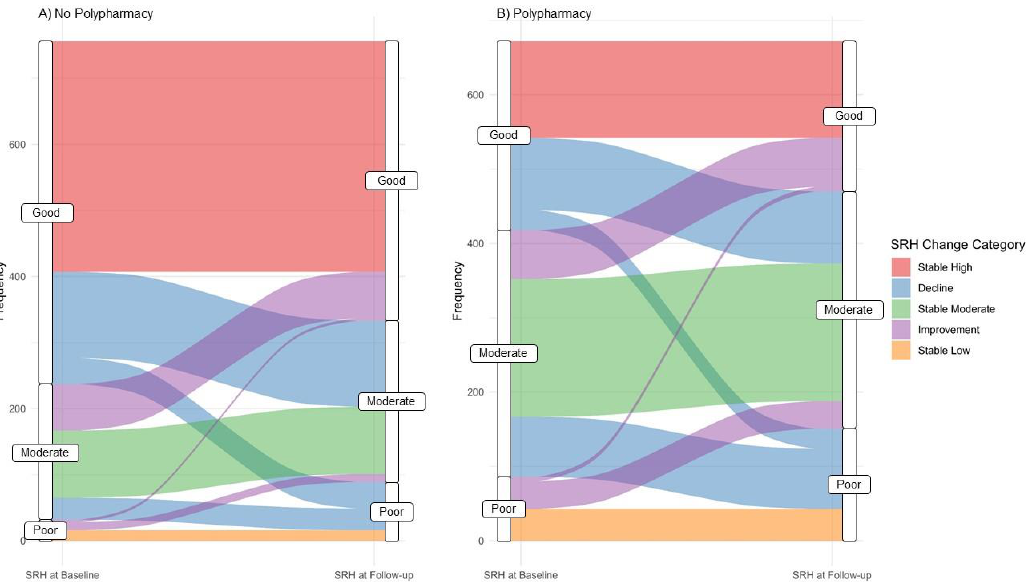
Figure 1. Transition in SRH reporting at baseline and follow-up in participants (A) without polypharmacy and (B) with polypharmacy. The flow of participants over the observation period represents the SRH change categories. The width of the lines is proportional to the number of participants.